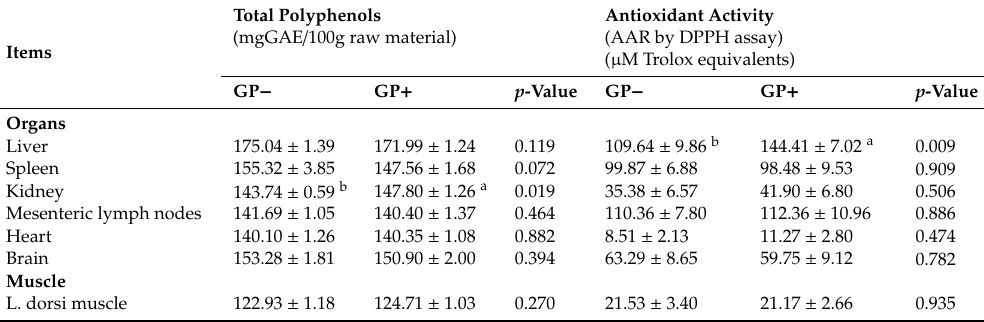
Table 5. The total polyphenols level (mg GAE / 100g raw material) and antioxidant activity-DPPH (AAR, Trolox Equivalents—TE) in organs (liver, spleen, kidney, mesenteric lymph nodes, heart and brain) and Longissimus dorsi muscle at the end of the trial.